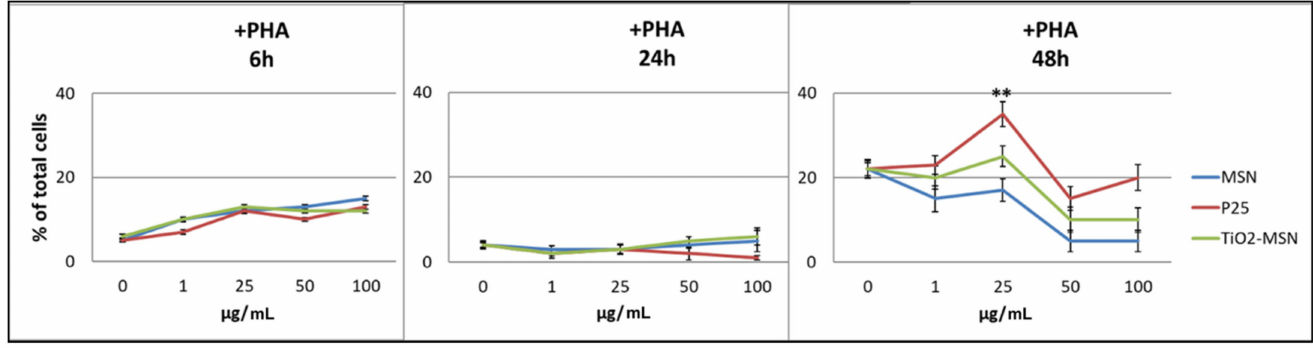
Figure 4. Apoptosis detection of PHA-stimulated PBMC by Annexin V staining. Significance values: ** p < 0.005; error bars represent the standard error of the